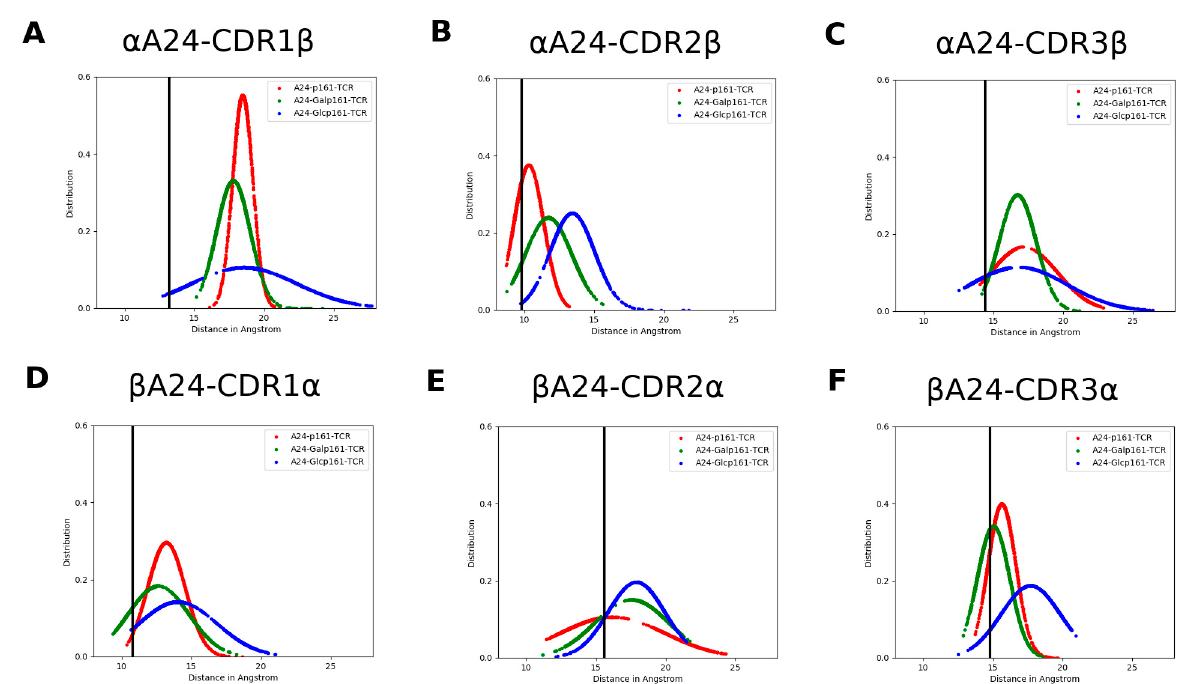
Figure 5. The distance distribution between A24 and TCR, namely ( A ) α A24 and CDR1 β , ( B ) α A24 and CDR2 β , ( C ) α A24 and CDR3 β , ( D ) β A24 and CDR1 α , ( E ) β A24 and CDR2 α , and ( F ) β A24 and CDR3 α in the MD simulations of the A24- peptide-TCR complexes where the peptides are p161 (red), Galp161 (green), and Glcp161 (blue). The black line is the corresponding distance in the crystal structure of the A24-HIV-TCR complex (PDB ID: 3VXU).